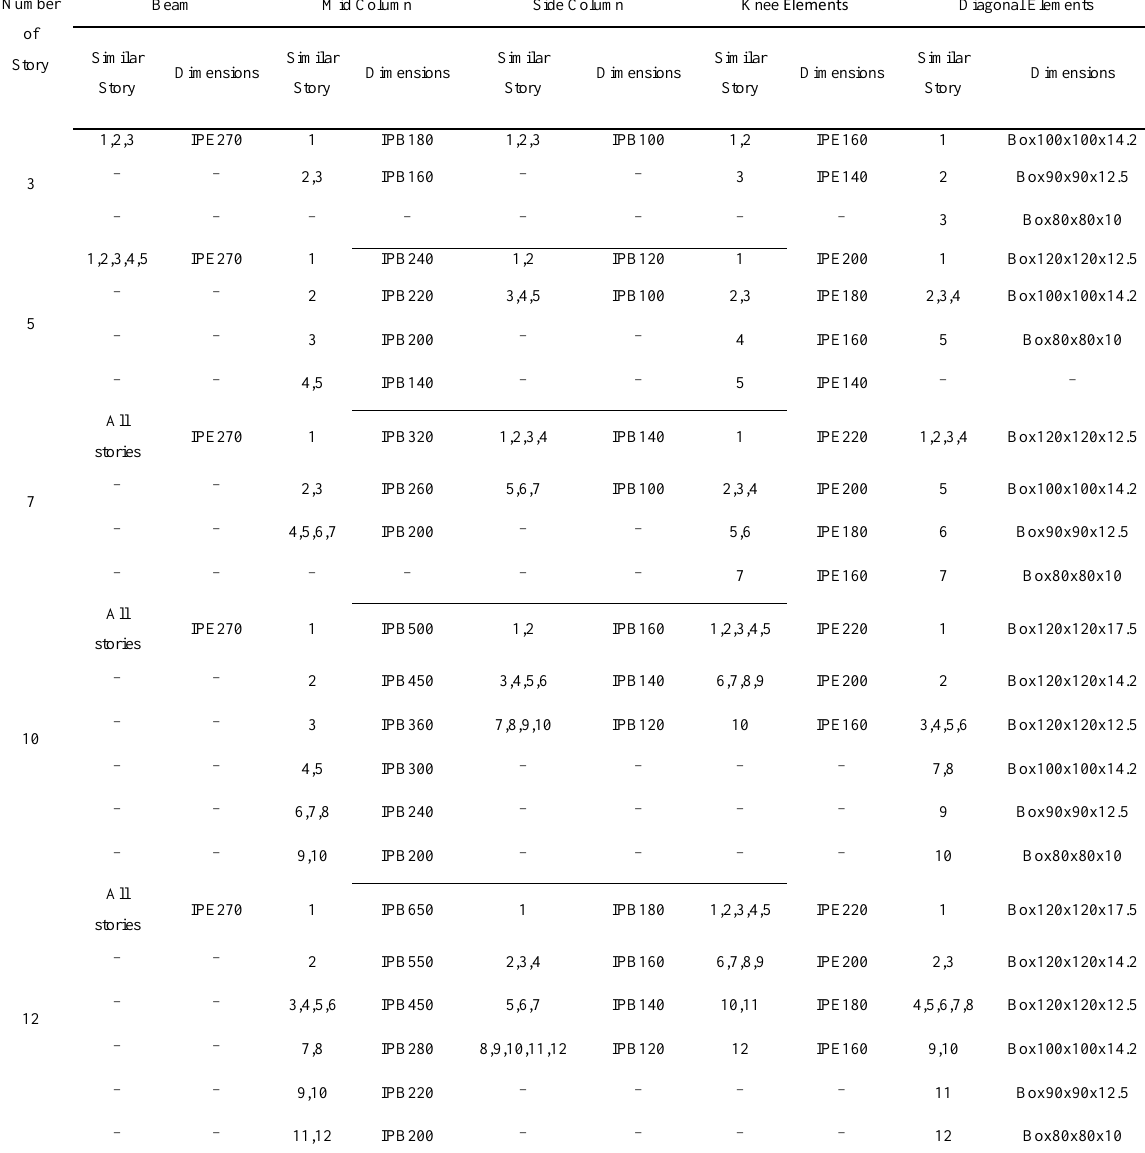
Table. 1. The member size for specimens.